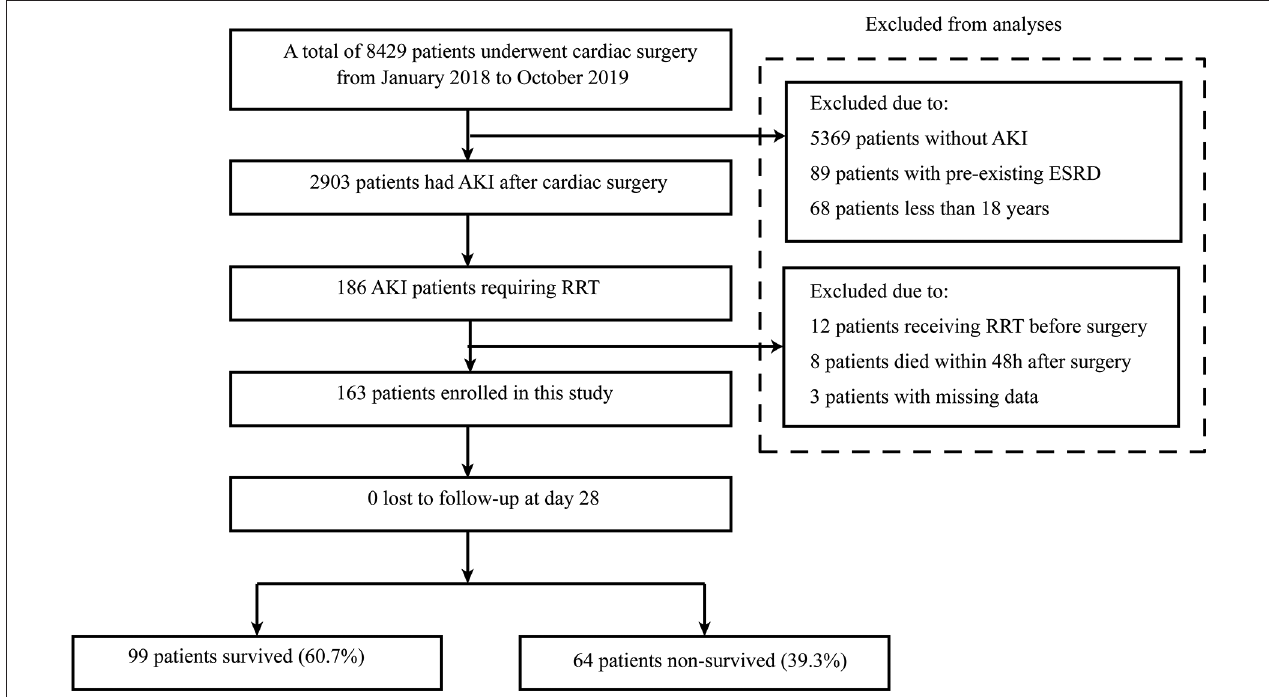
FIGURE 1 | Flow chart of this study. AKI, acute kidney injury; RRT, renal replacement therapy; ESRD, end-stage renal disease.